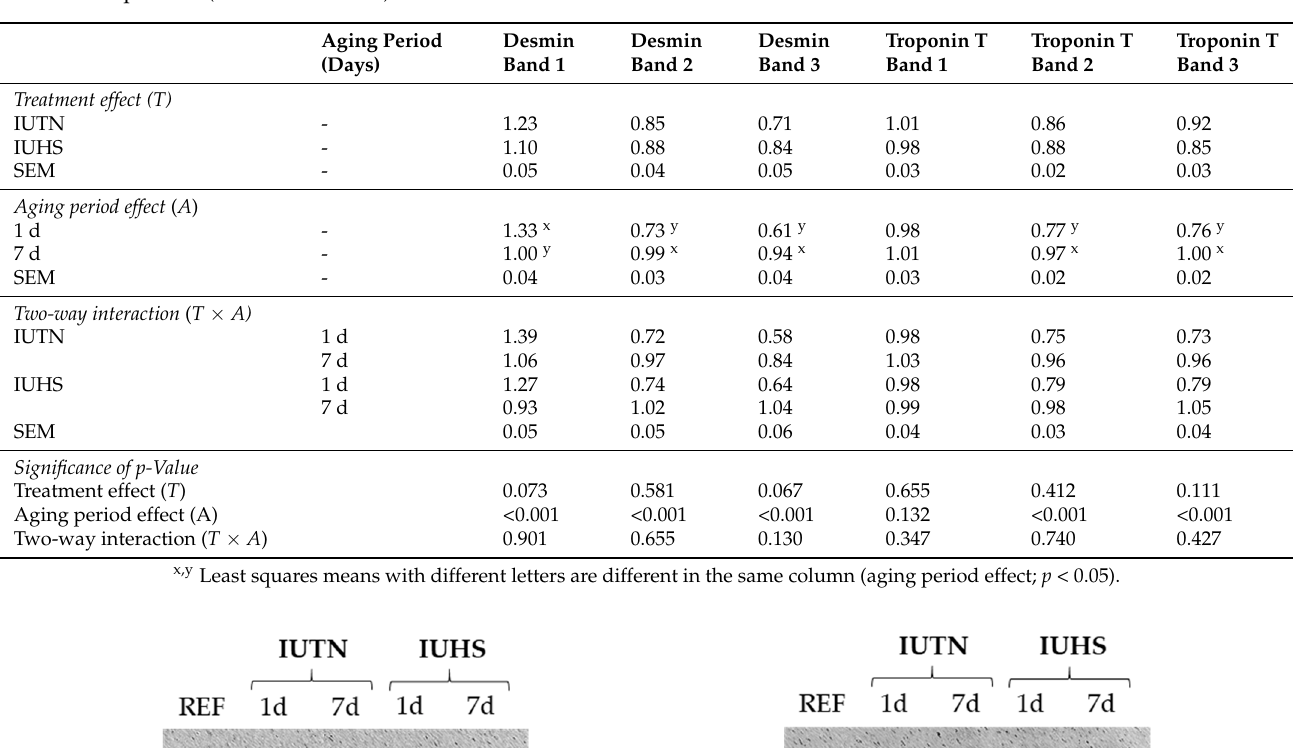
Table 5. Main and interactive effects of IUHS treatment and postmortem aging duration on relative abundance of desmin and troponin T ( n = 10/treatment).